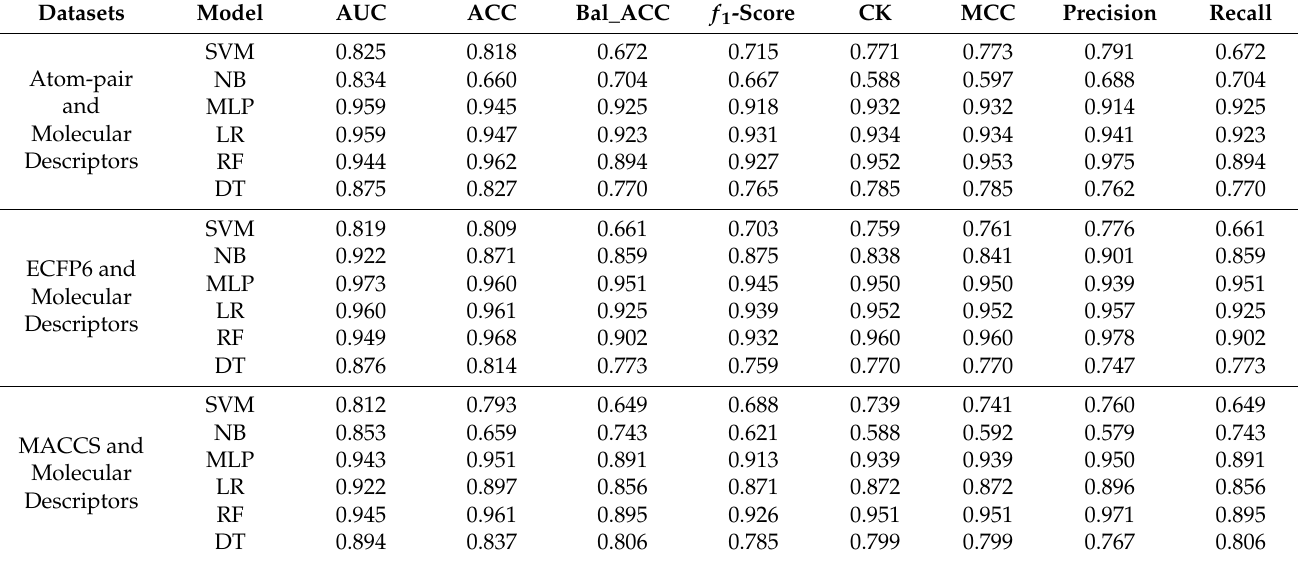
Table 3. Results of the Test Set on Each Dataset with Two Feature Types.